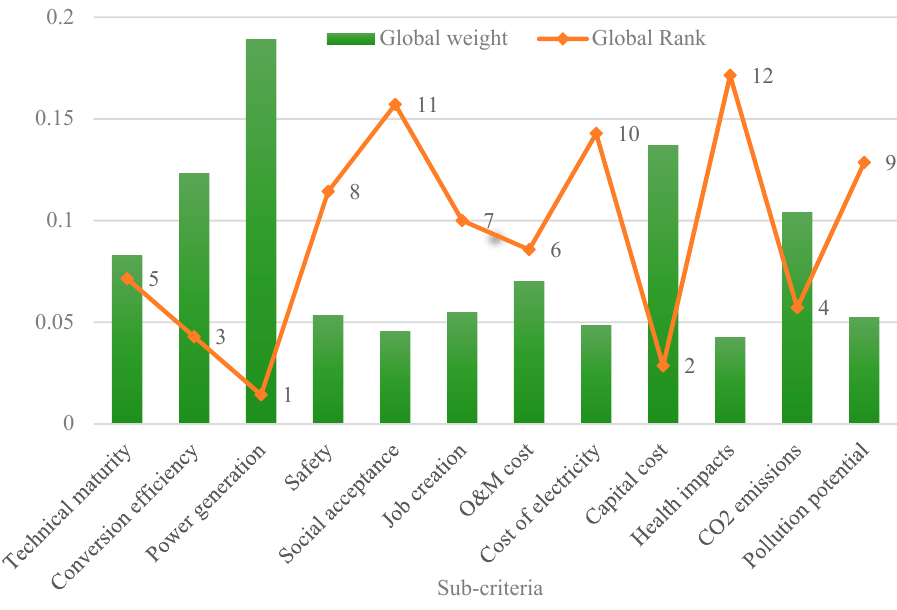
Figure 11. Overall priority weights and ranks of the